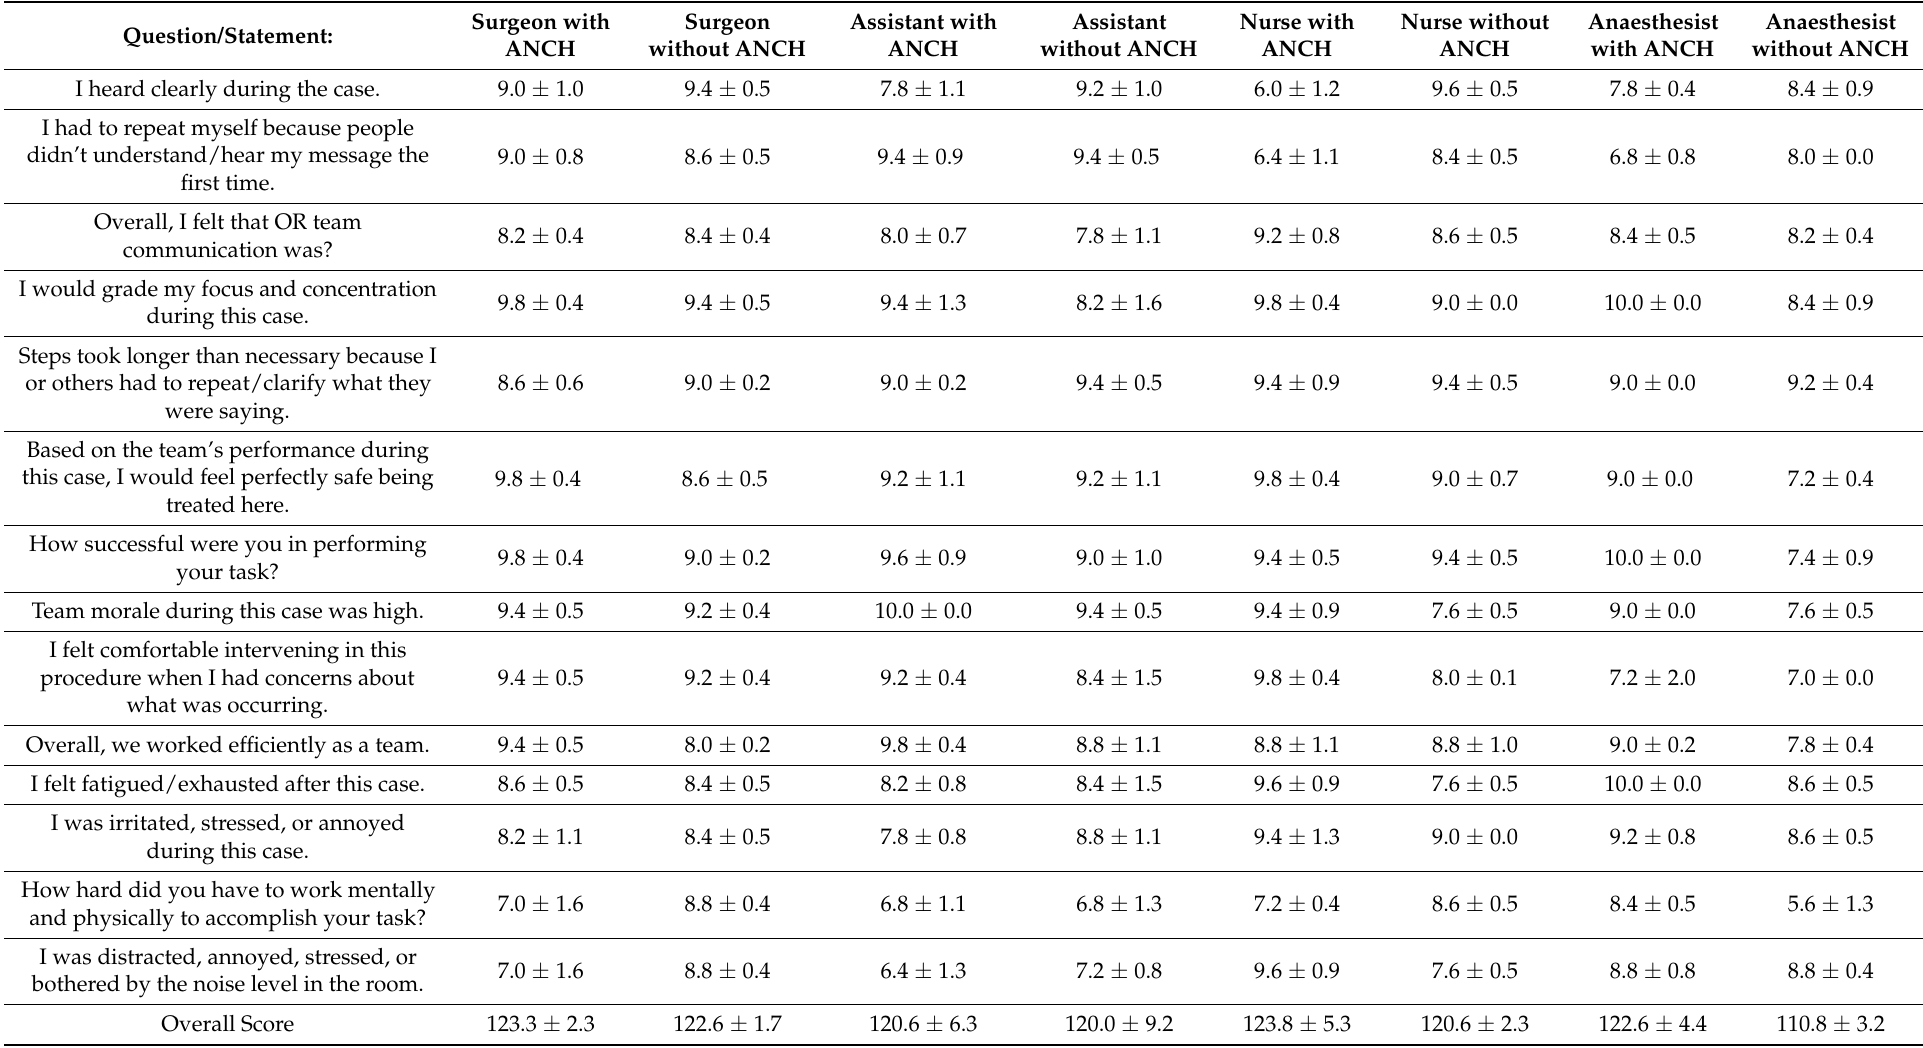
Table 1. Detailed results of the